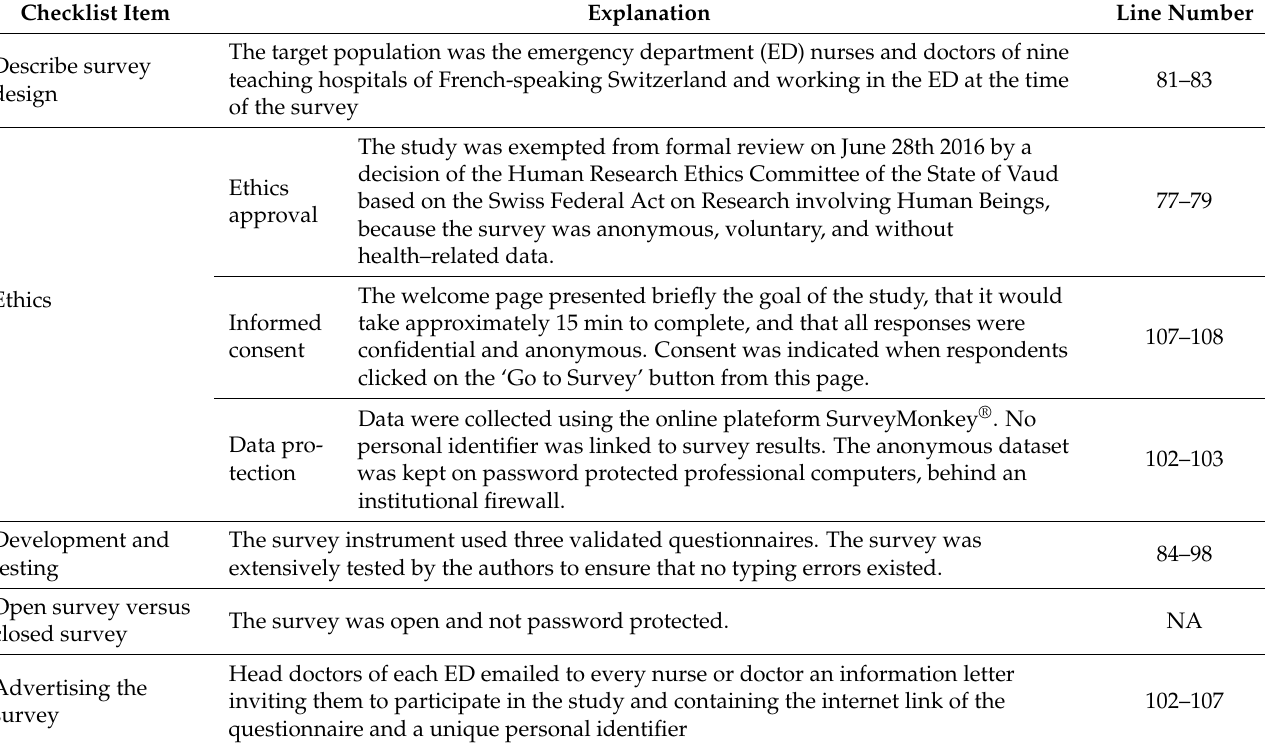
Table A2. Checklist for Reporting Results of Internet E-Surveys